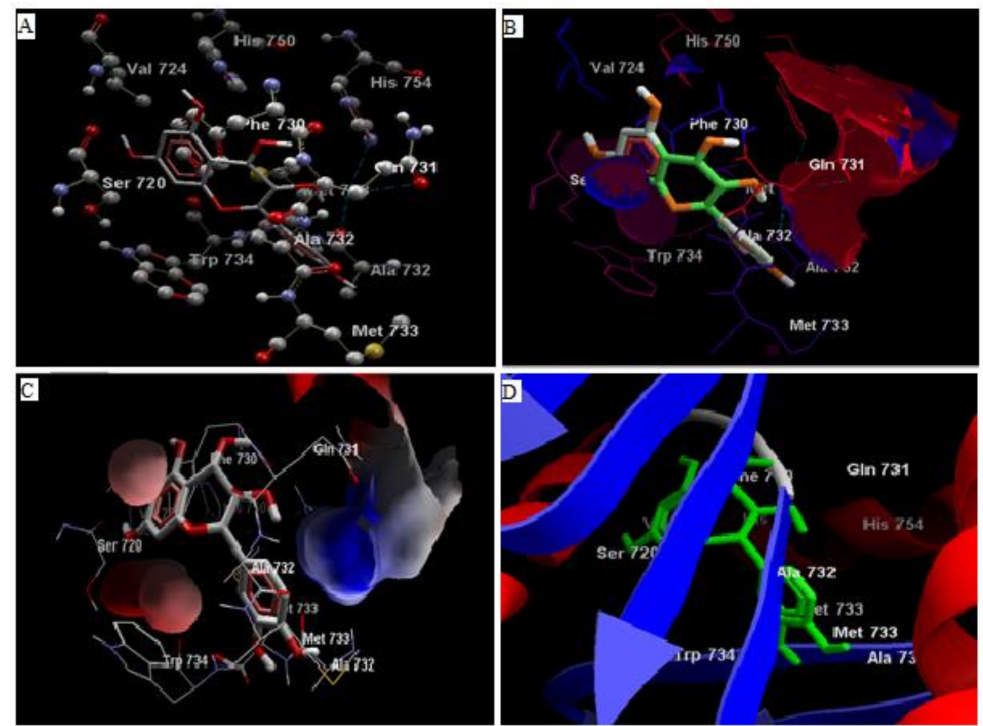
Figure 2. The hydrogen bonds ( A ), hydrophobic binding ( B ), electrostatic binding ( C ), and secondary protein interaction ( D ) of quercetin and dipeptidyl peptidase-IV protein.